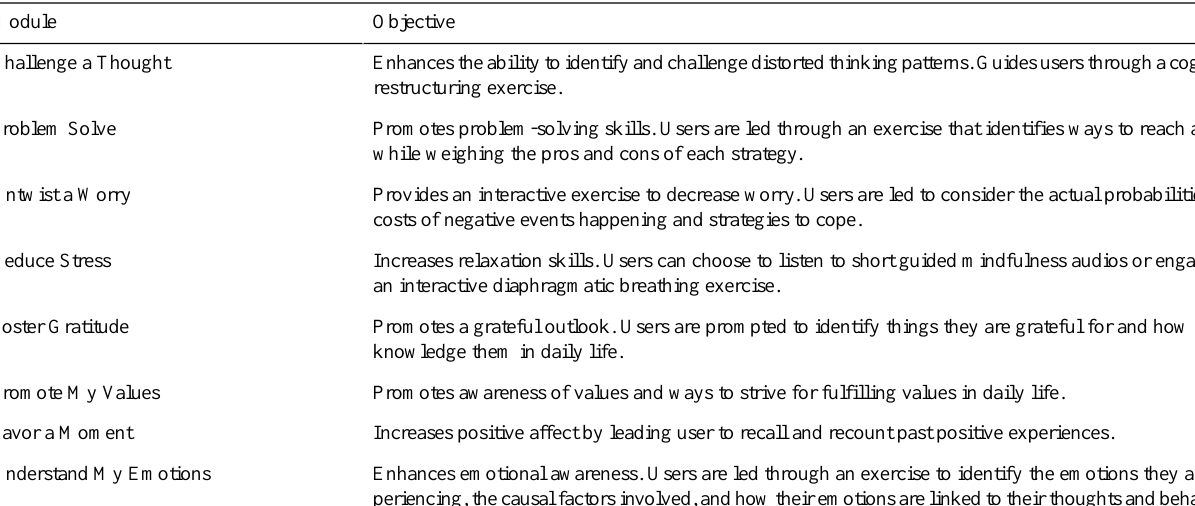
Table 1. Description of iCanThrive modules and their